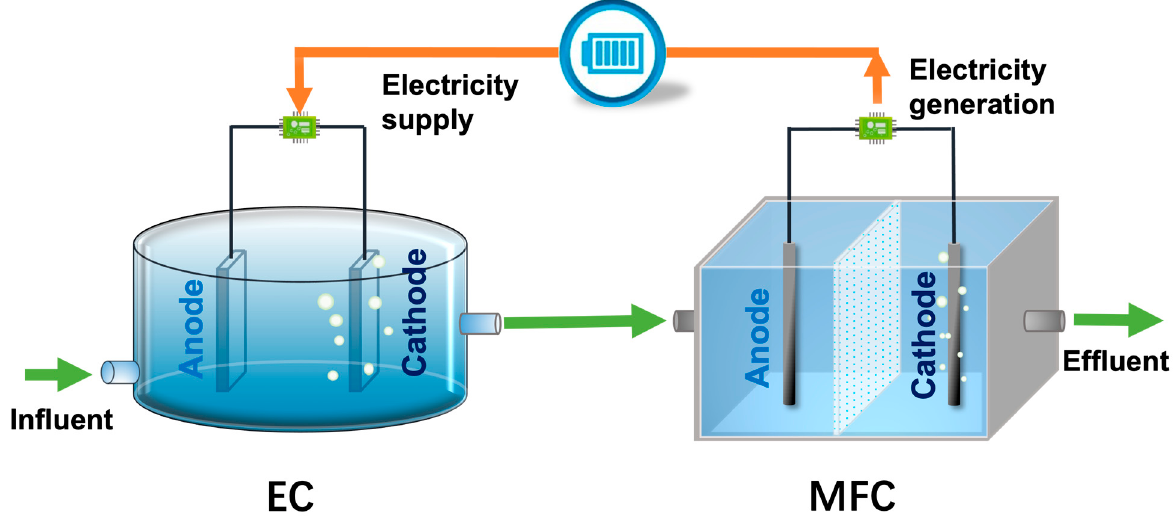
Figure 5. Schematic diagram of the EC powered by MFC.